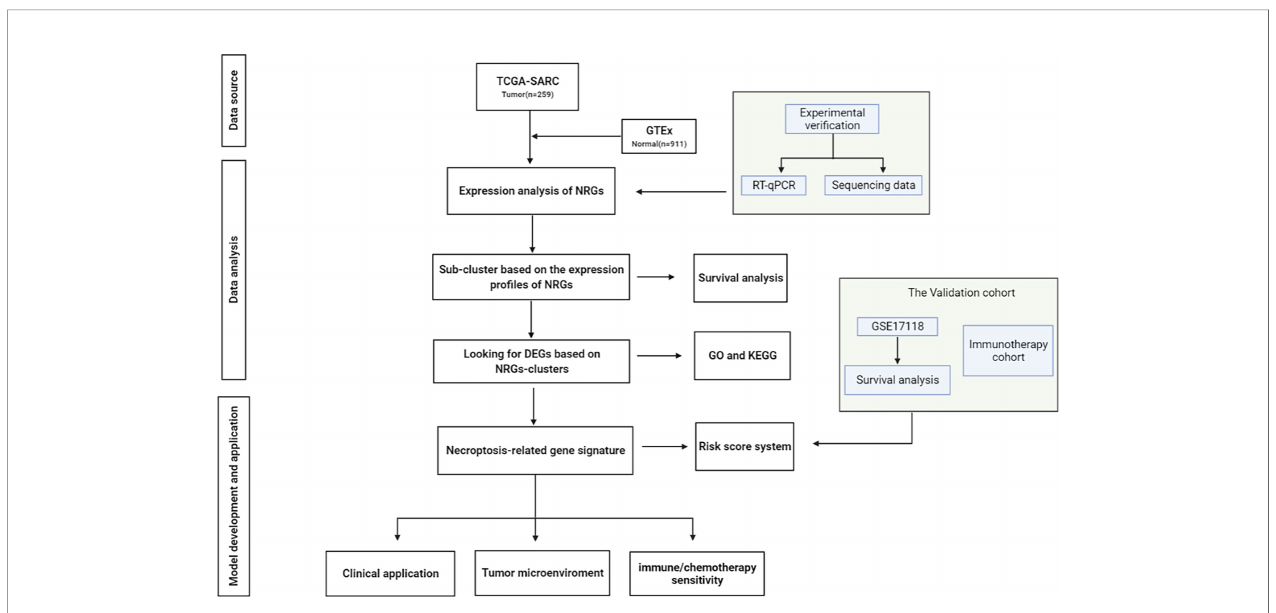
FIGURE 1 | Study design. Overall idea and fl ow